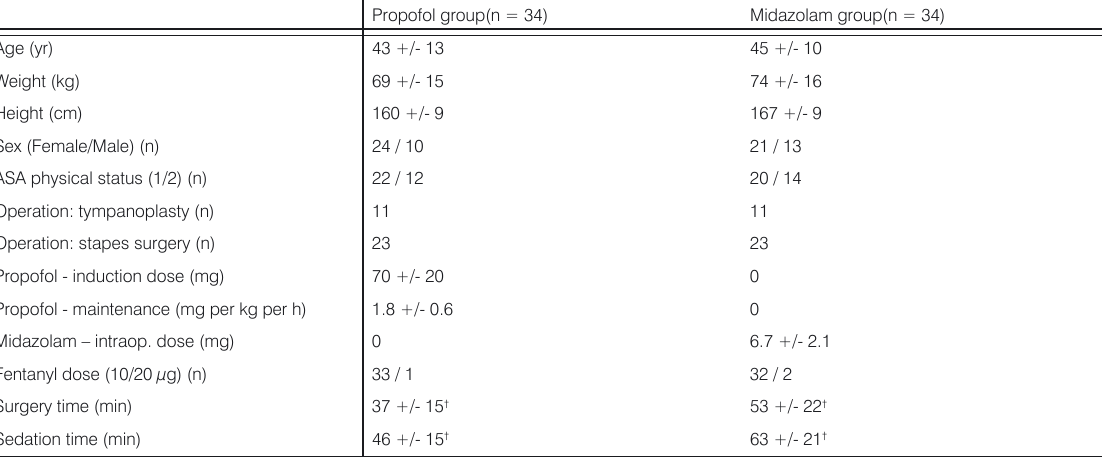
Table 1. Patient characteristics, intraoperative anaesthetic and analgesic requirements, and surgical data for the two